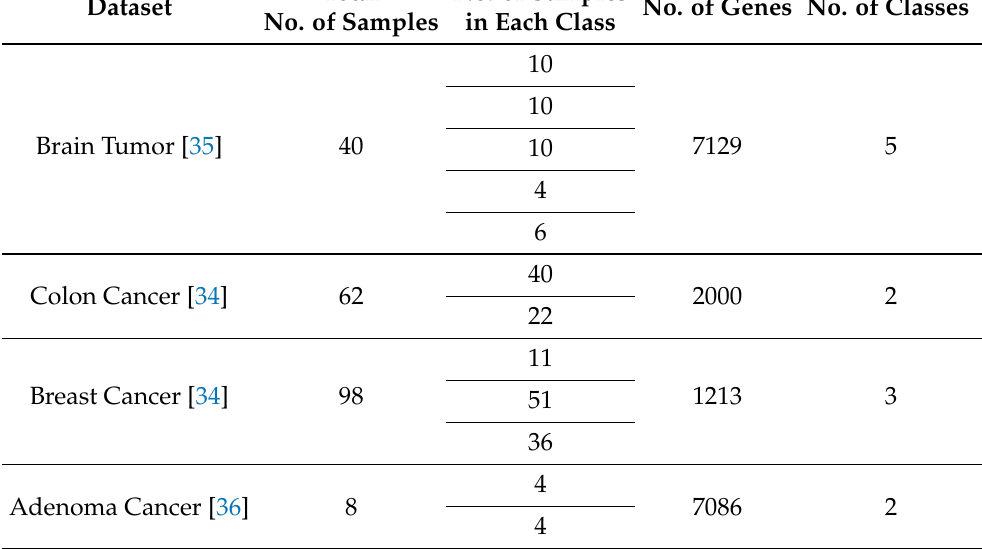
Table 2. Description of microarray